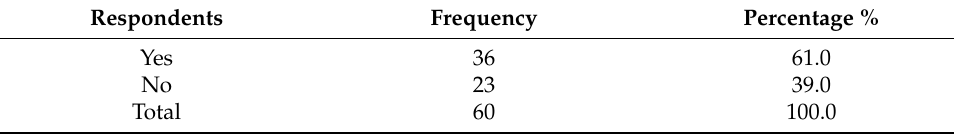
Table 16. In comparison to our competition, our firm is highly valuable.